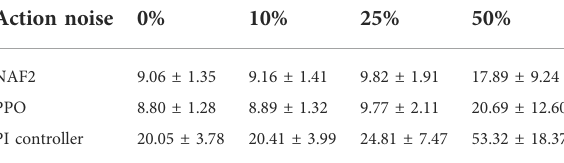
TABLE4Thestatistics(mean±std.)fortheepisodelengthobtainedby the best RL agents trained in Section 4 and PI controller with respect to the amplitude of Gaussian action noise.